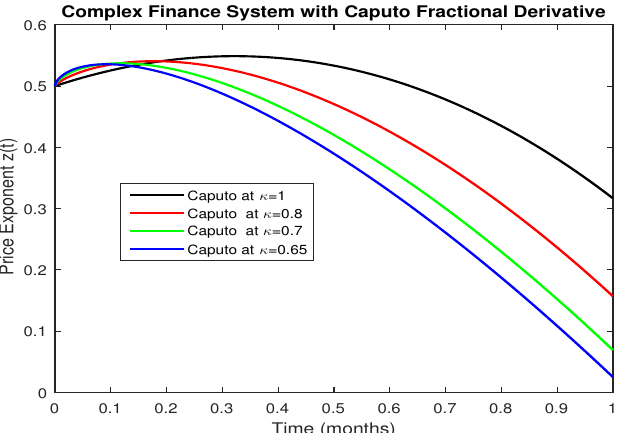
Figure 3. z ( t ) price exponent with Caputo fractional